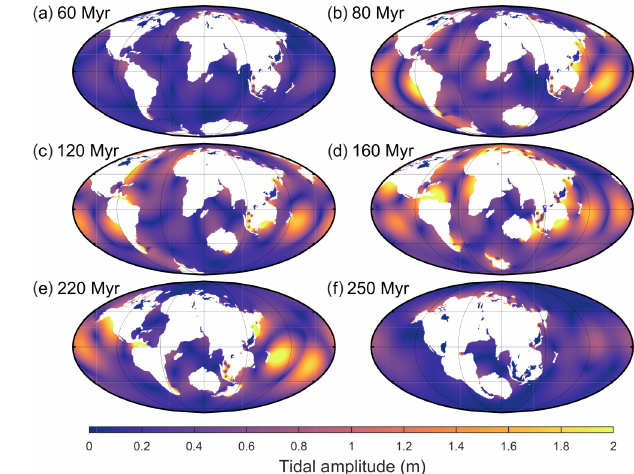
Figure 2. Global M 2 amplitudes for six representative time slices of the Pangaea Ultima scenario. The colour scale saturates at 2m. For the full set of time slices covering every 20Myr, see the Supple- ment. Additionally, note that the figures presented for each scenario display different time slices to highlight periods with interesting tidal signals and that the centre longitude varies between panels to ensure the supercontinent forms in the middle of each figure (where